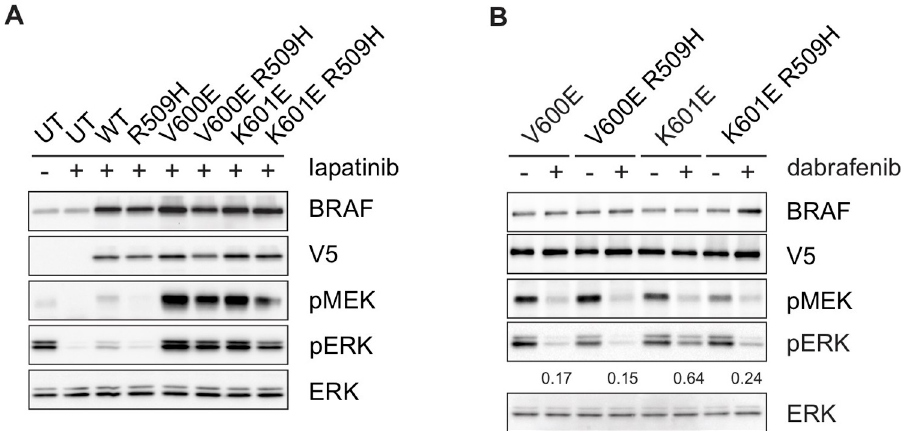
Fig 5. BRAF K601E requires dimerization for activity. A-B. V5-tagged BRAF mutants (WT/ R509H/ V600E/ V600E R509H/ K601E/ K601E R509H) were expressed in SKBR3 cells overnight, followed by lapatinib treatment (1uM for 1 hour) only (A), then followed by treatment with DMSO or dabrafenib (200nM) for 1 hour (B). UT = untransfected. Expression and/or phosphorylation of the indicated proteins were assessed by immunoblot. Phospho-ERK levels for dabrafenib treatment are given as a percent of pERK expression in the untreated sample, for each individual mutation, normalized for V5 expression.